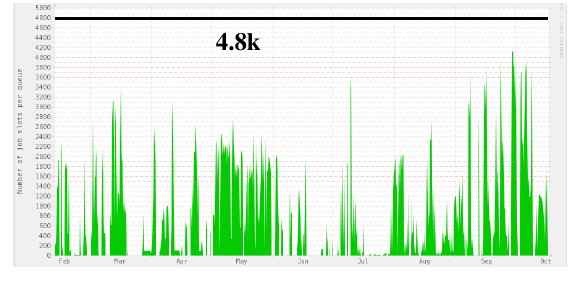
Figure 4. Number of batch